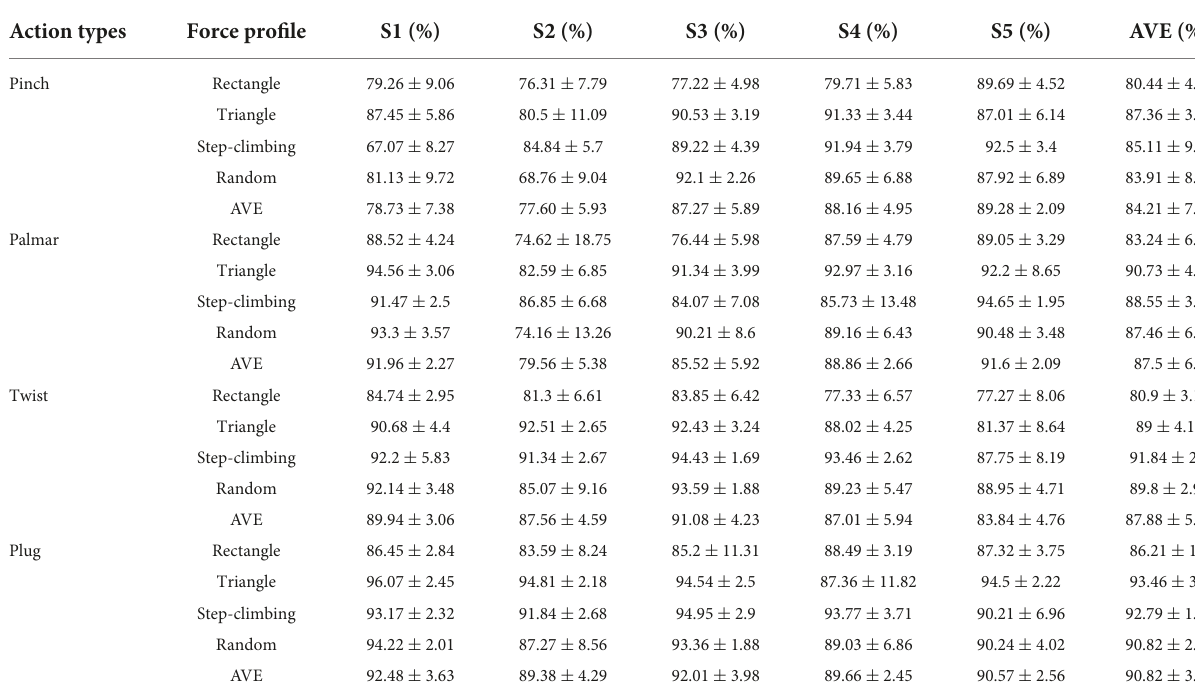
TABLE 4 Coefficient of determination for each